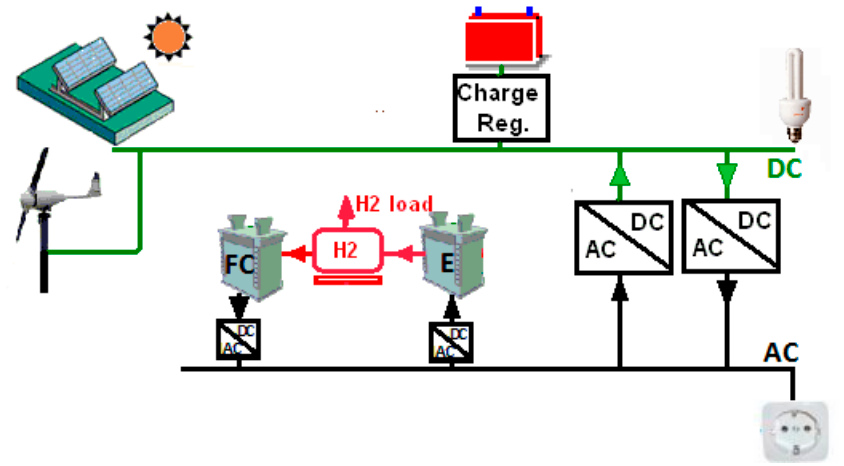
Figure 13. Energy sources used for iHOGA with FC and electrolyzer.